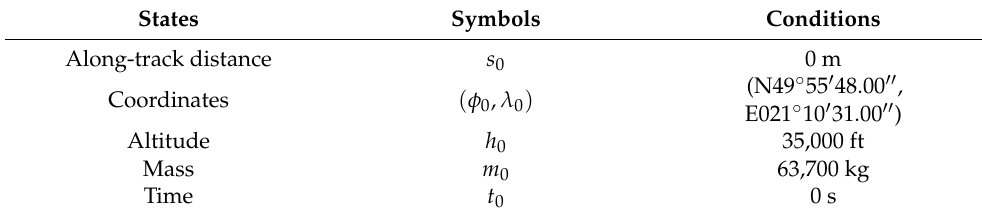
Table 2. Initial states for the waypoint